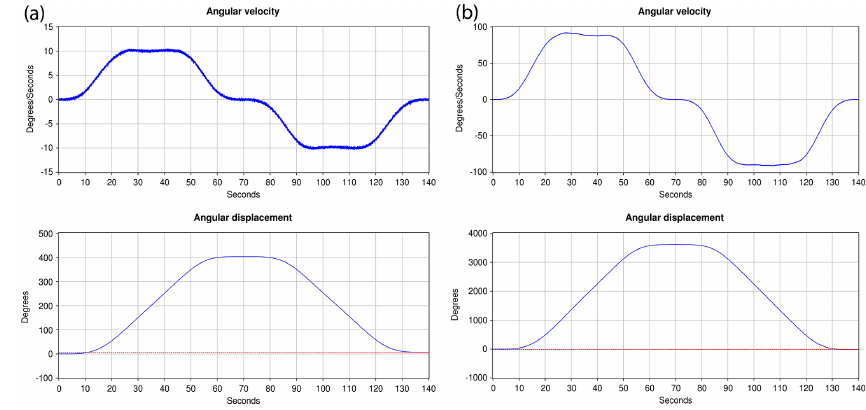
Figure 7. Signals recorded by a MEMS sensor during the rotation test at angular rate of (a) 10 and (b) 90 ◦ s − 1 . The dashed red line indicated the real stop position of the rotating table.